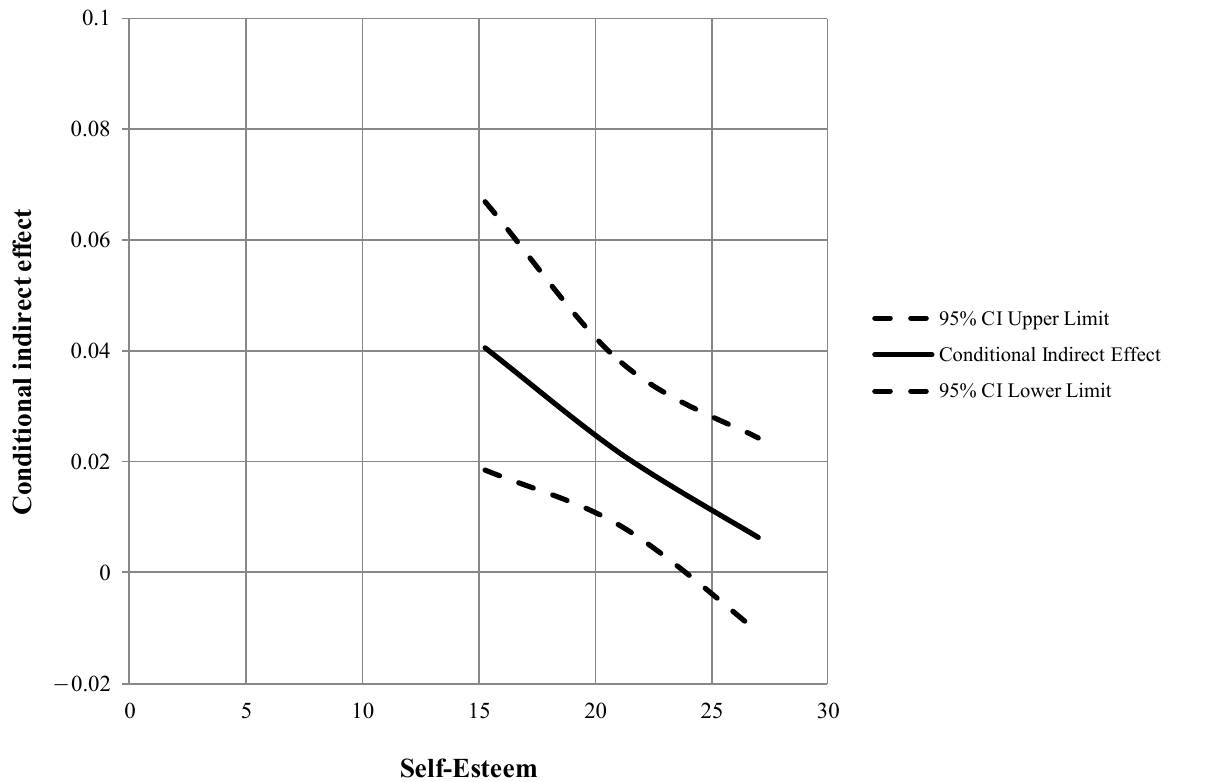
Figure 2. Conditional indirect effect of alexithymia on social media addiction at values of the moderator self-esteem through dysmorphic symptoms.